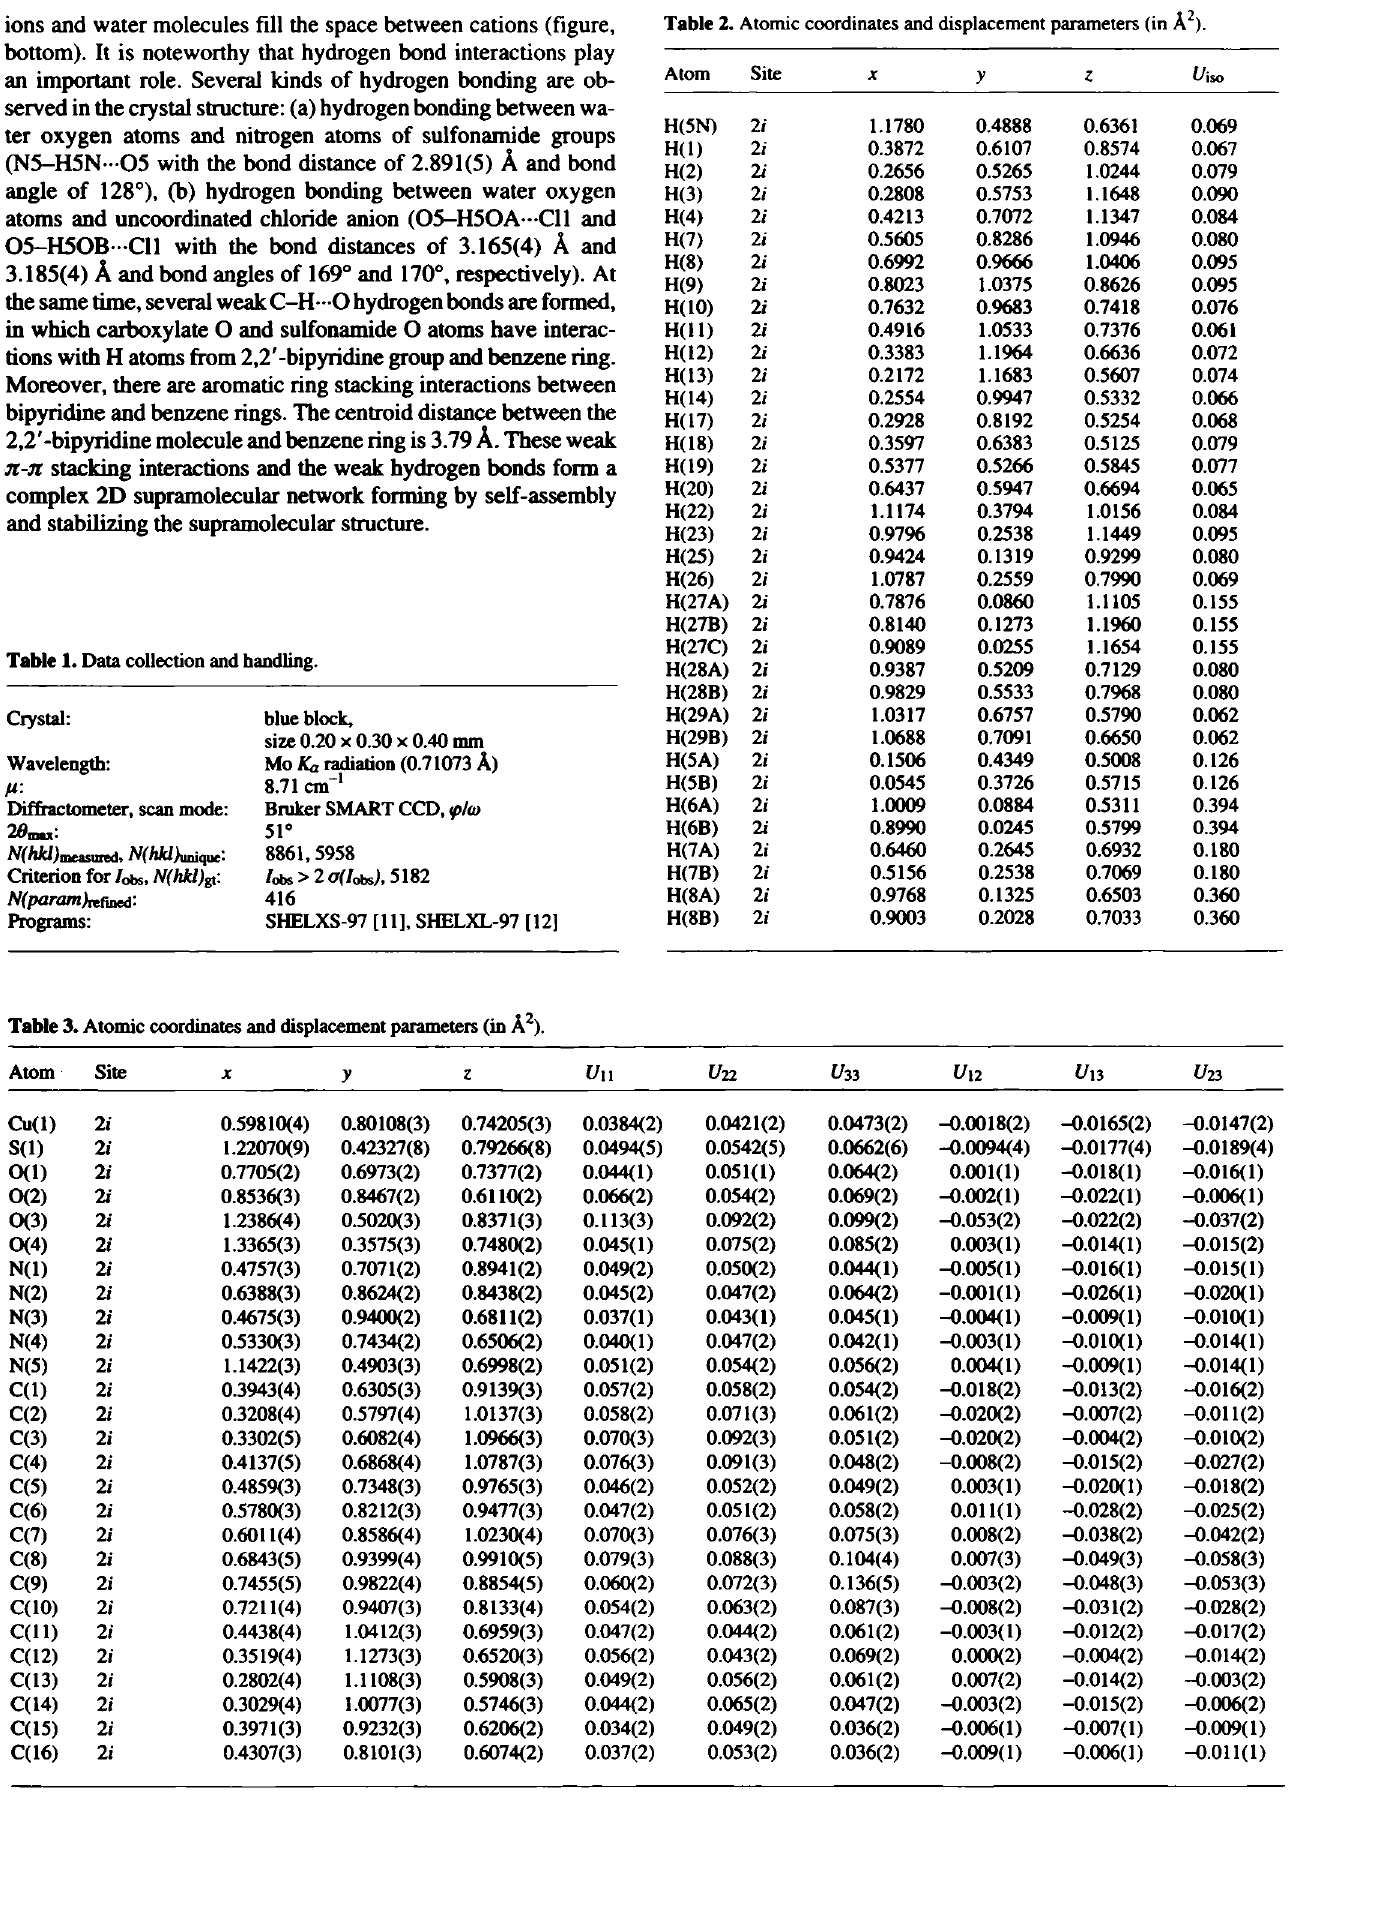
Table 2. Atomic coordinates and displacement parameters (in Ä 2 ).